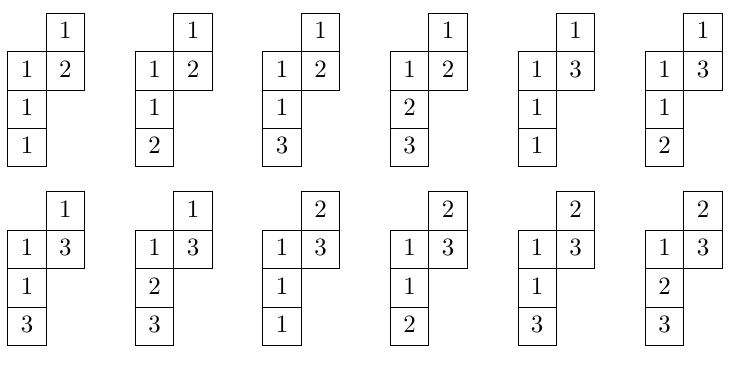
Figure 1 . Allowed su(1 j 2) Young tableaux for the motif (0 ; 1 ; 0 ;